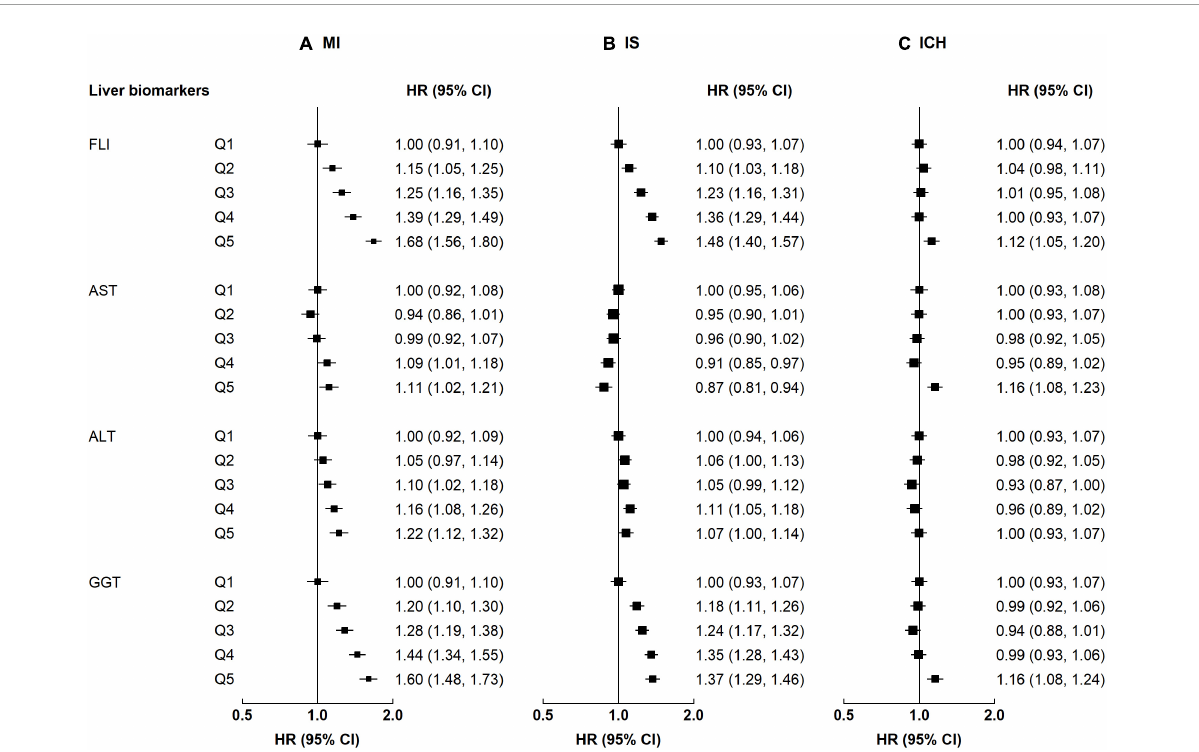
FIGURE1 Associations of liver biomarkers with risk of CVD. Columns (A–C) denote the results for MI, IS, and ICH, respectively. Boxes represent the hazard ratios (HRs) of CVD associated with liver biomarkers, with the size of the box inversely proportional to the variance of the logHR. The model is adjusted for age, sex, regions, education, smoking, and alcohol.